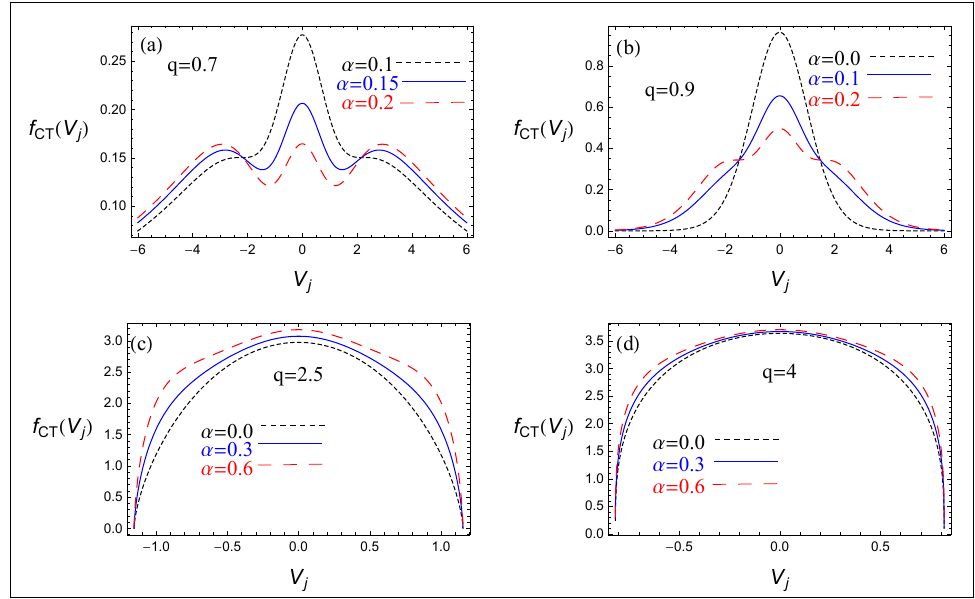
Figure 1. (Color online) normalized ( q , α ) -distribution function ( a ) α ( 0.1,0.15,0.2 ) with q = 0.7 ( b ) α ( 0.0,0.1,0.2 ) with q = 0.9 ( c ) α ( 0.0,0.3,0.6 ) with q = 2.5 and ( d ) α ( 0.0,0.3,0.6 ) with q =